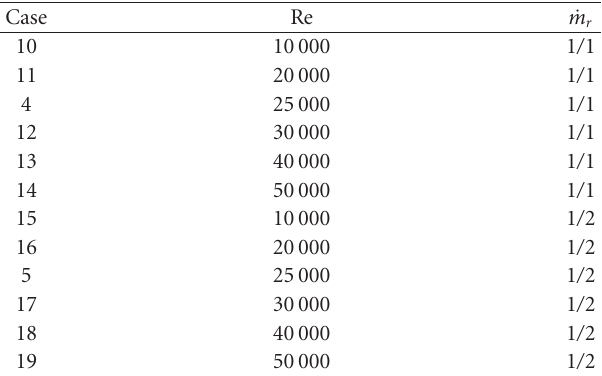
Figure 3: Axial velocity profiles at di ff erent sections of the cooling channel for Re = 10000 and ˙ m r = 1 / 1.